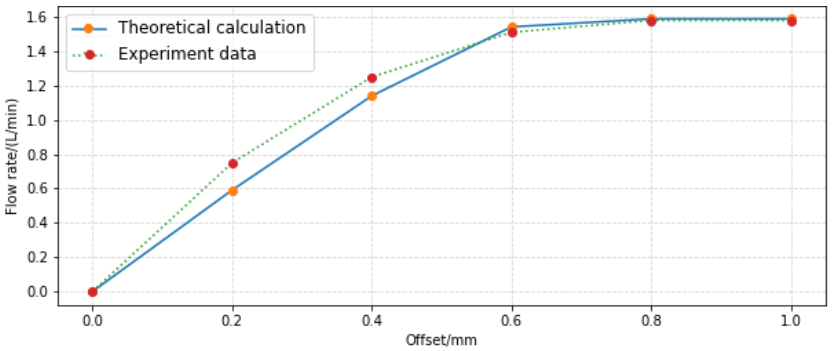
Figure 18. Comparison between theoretical flow model and experiment.